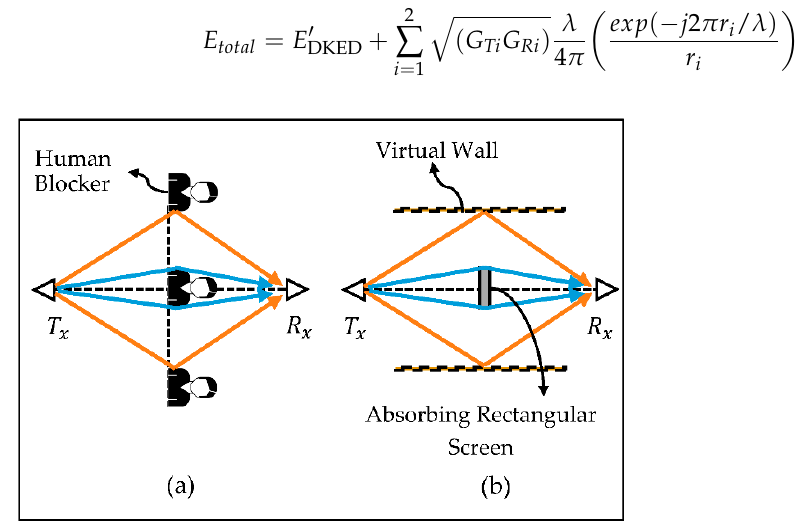
Figure 6. ( a ) Illustration of the measurement scenario; ( b ) Propagation model (top view).